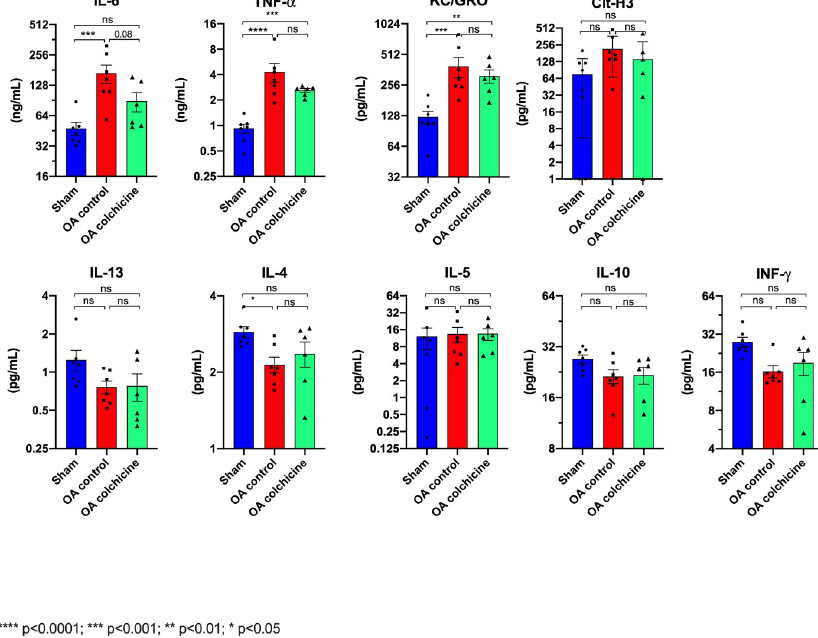
Fig 3. Effects of colchicine therapy on plasma cytokines and NETs 4 hours after oleic acid ALI. Values are mean ± SEM. ���� p < 0.0001; ��� p < 0.001, �� p < 0.01; � p < 0.05.